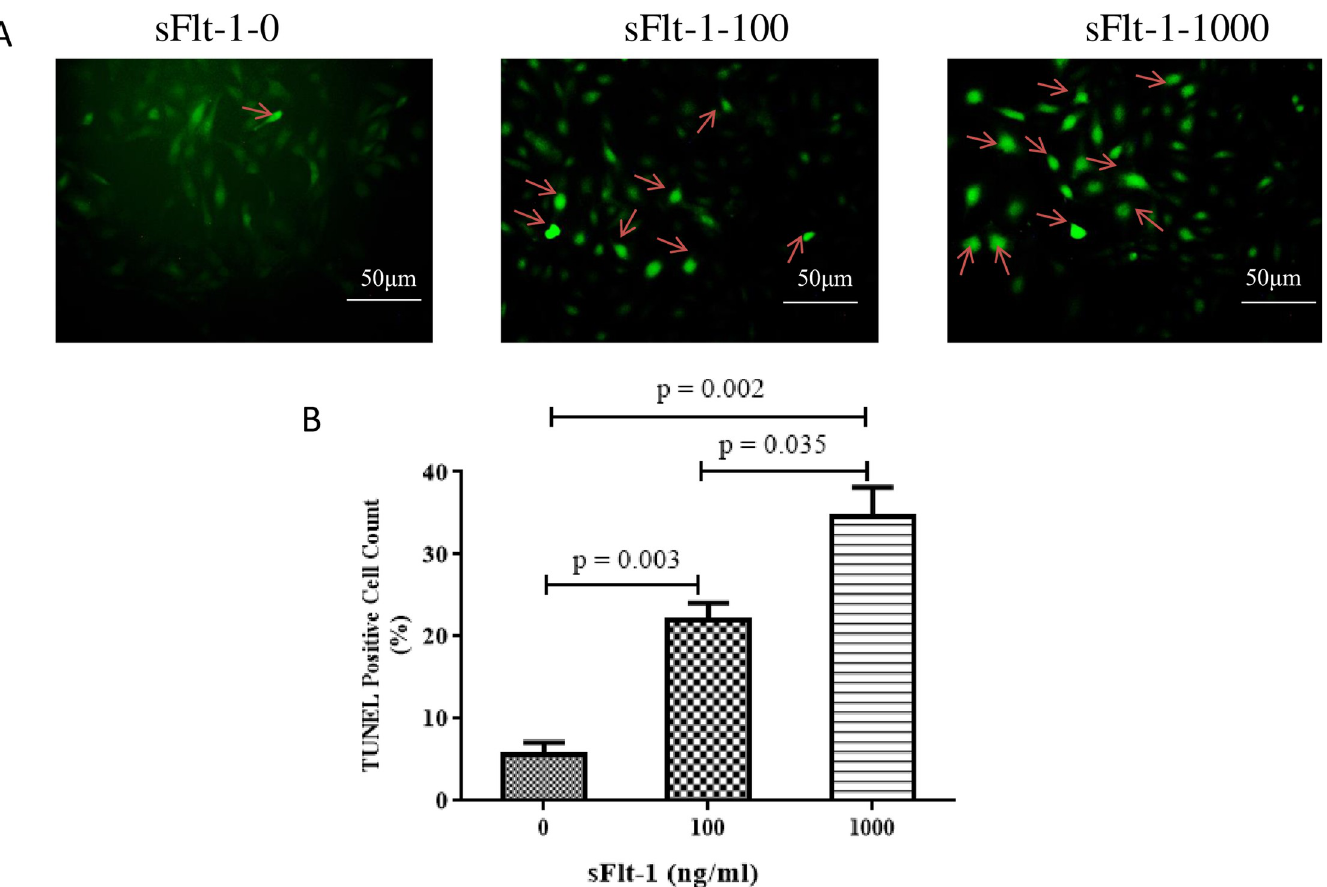
Fig 5. The apoptosis rate of HUVECs was measured using TUNEL assay. The figure showed a representative set of the graph of apoptosis rate of HUVECs by TUNEL staining. A: the indicated concentrations of sFlt-1-treated group, and B: statistical result of apoptosis rate of HUVECs in different groups. TUNEL analysis showed that sFlt-1 could induce an abundance of apoptosis in a dose-dependent manner (100 ng/ml vs. 0 ng/ml: 22.0 ± 3.60% vs. 5.67 ± 2.52%, p = 0.003; 1000 ng/ml vs. 0 ng/ml: 34.67 ± 6.03% vs. 5.67 ± 2.52%, p = 0.002; 1000 ng/ml vs. 100 ng/ml: 34.67 ± 6.03% vs. 22.0 ± 3.60%, p = 0.035). Results are the means ± standard deviation of three independent experiments. Scale bar denotes 50 μ m. Arrows indicate TUNEL-positive